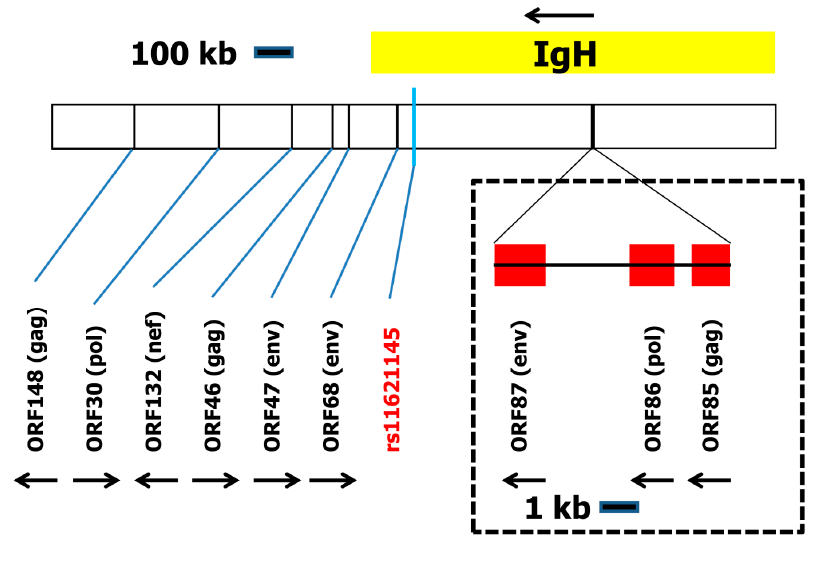
Figure 3. Schematic organization of the immunoglobulin locus including rs11621145 on human chromosome 14. The two megabase pairs flanking rs11621145 were analyzed using getorf for the presence of open reading frames (ORFs) with a minimal length of one kilobase. One hundred and sixty-nine ORFs were identified (see Supplementary Table S3). These ORFs were analyzed using BLASTP against the database of retro-transcribing viruses (taxid:35268). Nine ORFs with sequence similarity to retroviruses were identified. A cluster of three ORFs forming a retrovirus-like composite element is located between the HOMER homolog 2 pseudogene 2 and the solute carrier family 20 member 1 pseudogene 2 in the immunoglobulin heavy chain (IGH) locus. For a complete list of all genes in this chromosomal region, see Supplementary Table S4. Arrows indicate the direction of the ORFs.